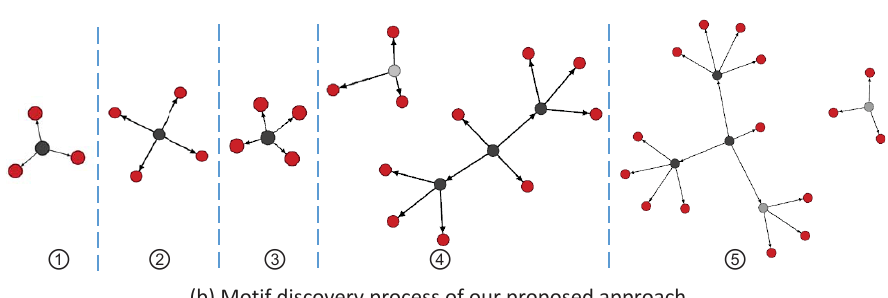
Figure 5. Motif discovery procedure of our proposed approach: ( a ) overview of the network worm propagation process and the ( b ) motif discovery process of the proposed